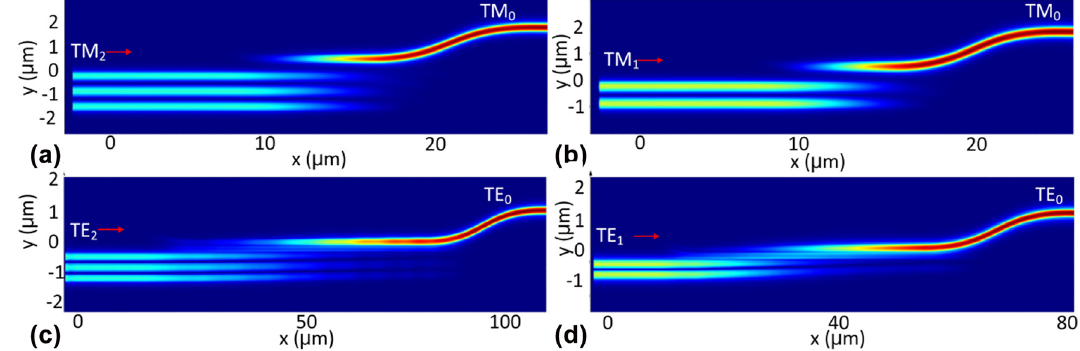
(a), TM (b), TE (c), and TE (d) in the corresponding coupler at 1550 nm 2 1 2 1